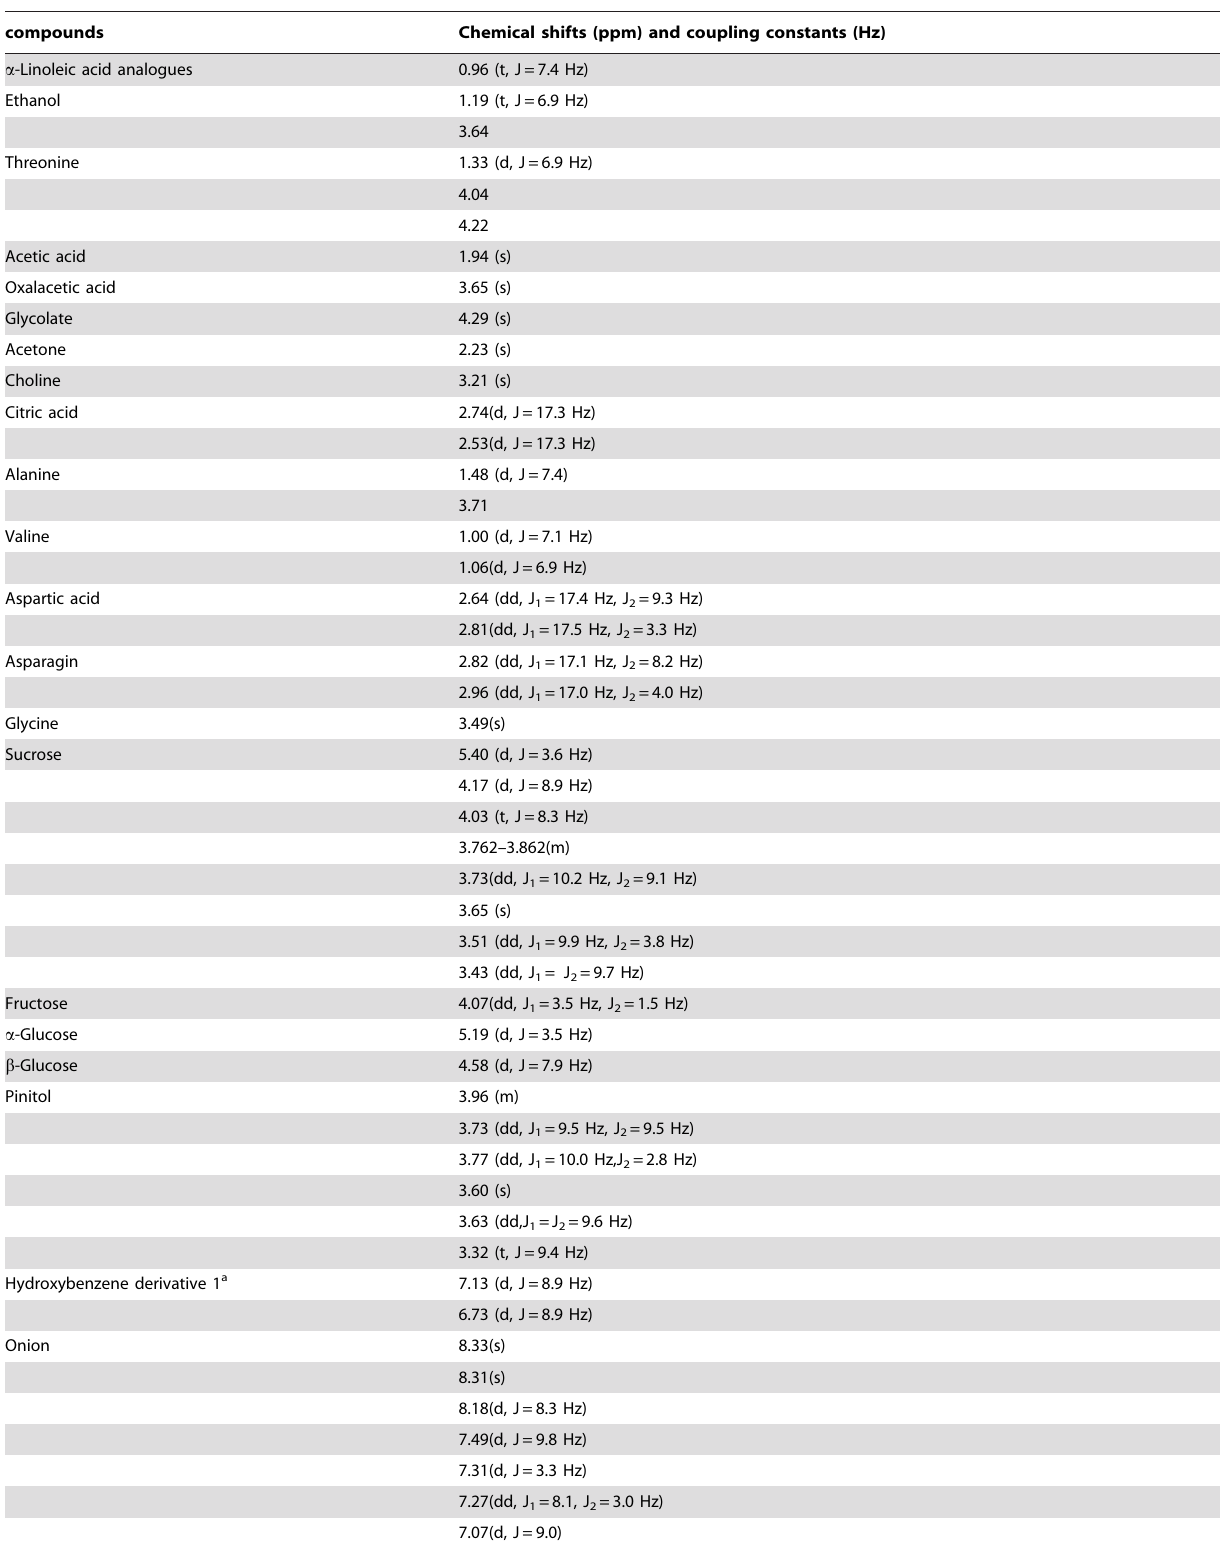
Table 1. 1 H chemical shifts and coupling constants (J, Hz) of metabolites in A. mongolicus roots identified (CD 3 OD-KH 2 PO 4 in D 2 O, pH